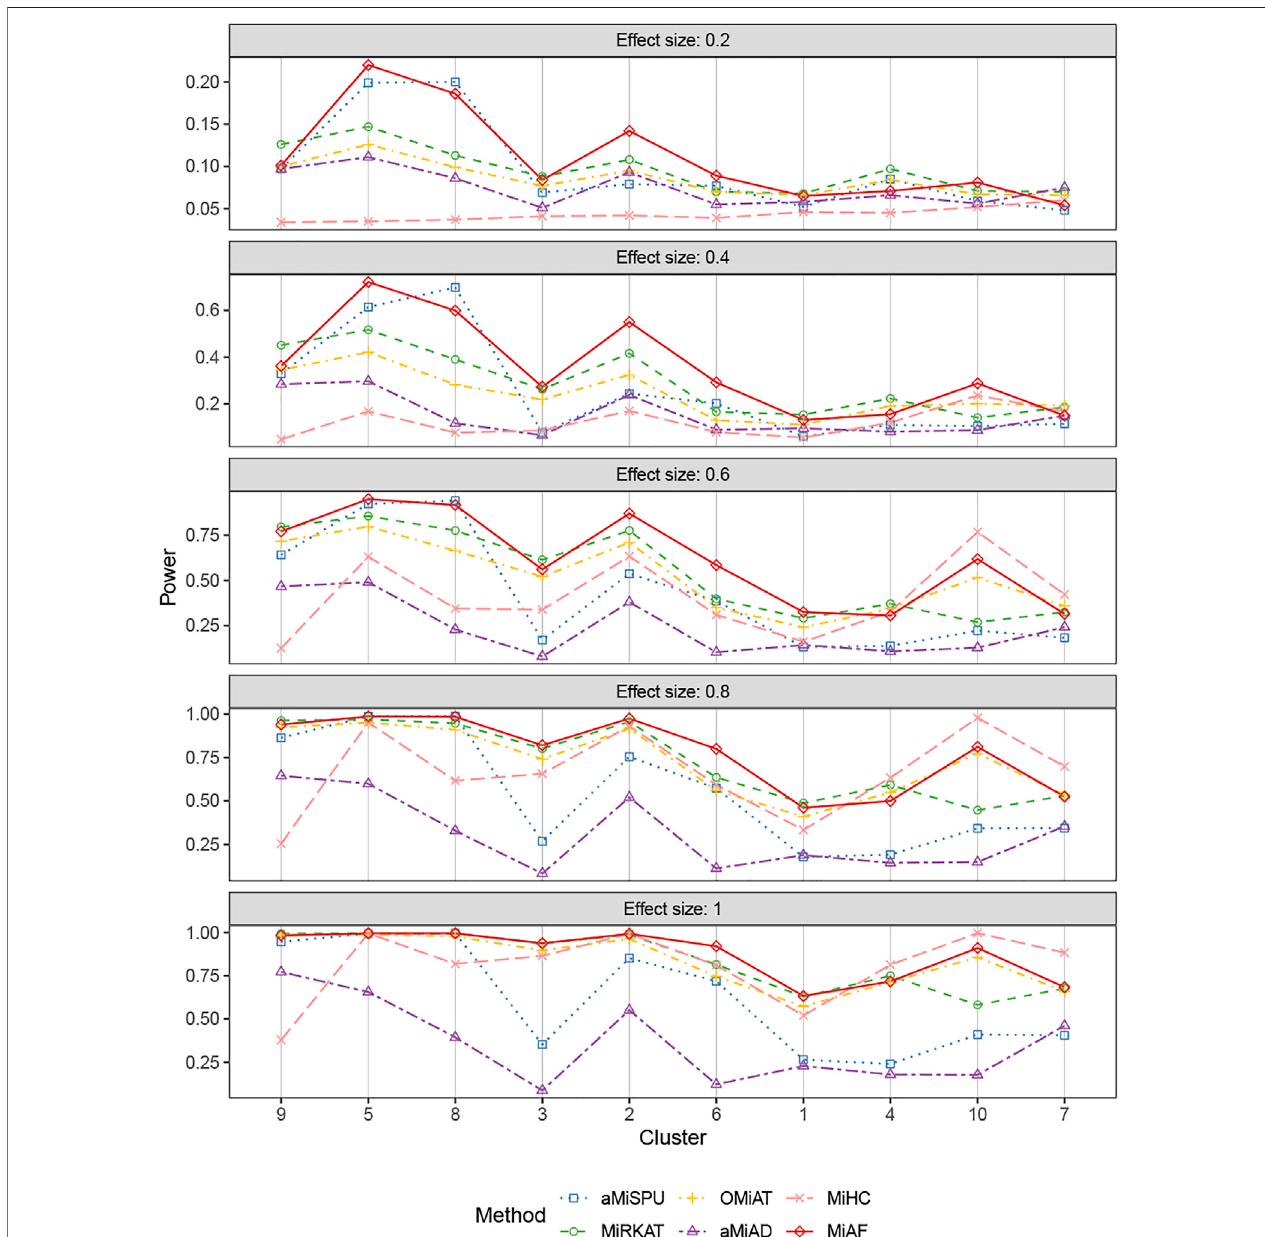
FIGURE 4 | Power comparison for continuous outcomes under the independent case of scenario 2. A total of 616 OTUs were divided into 10 clusters. The covariates Z i 2 and OTUs X i · were independent. The effect size was set as 0.2, 0.4, 0.6, 0.8 and 1. The 10 clusters were sorted by the sum of estimated mean absolute abundance of the OTUs within the cluster that was truly associated from the greatest to the